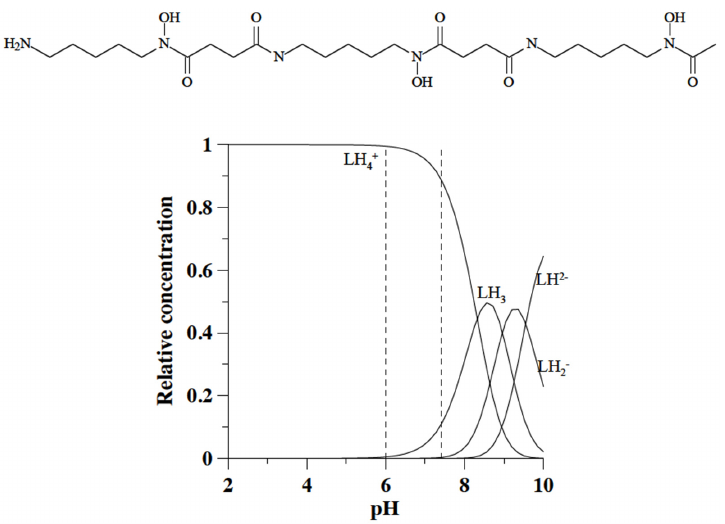
Fig 1. Molecular formula of deferoxamine and speciation plots of its variously protonated forms.